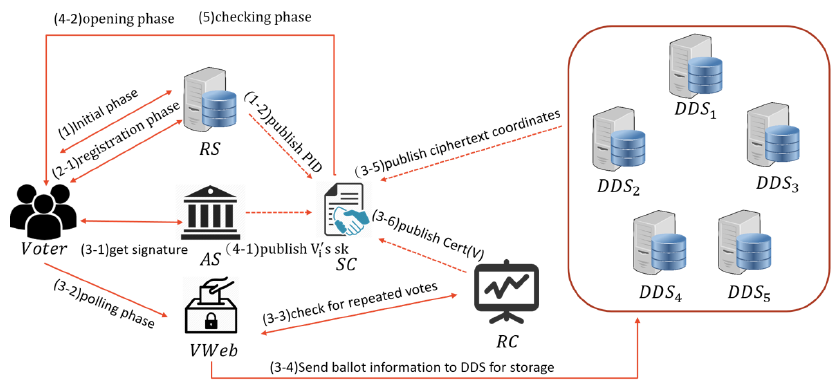
Figure 2. Architecture of our E-voting